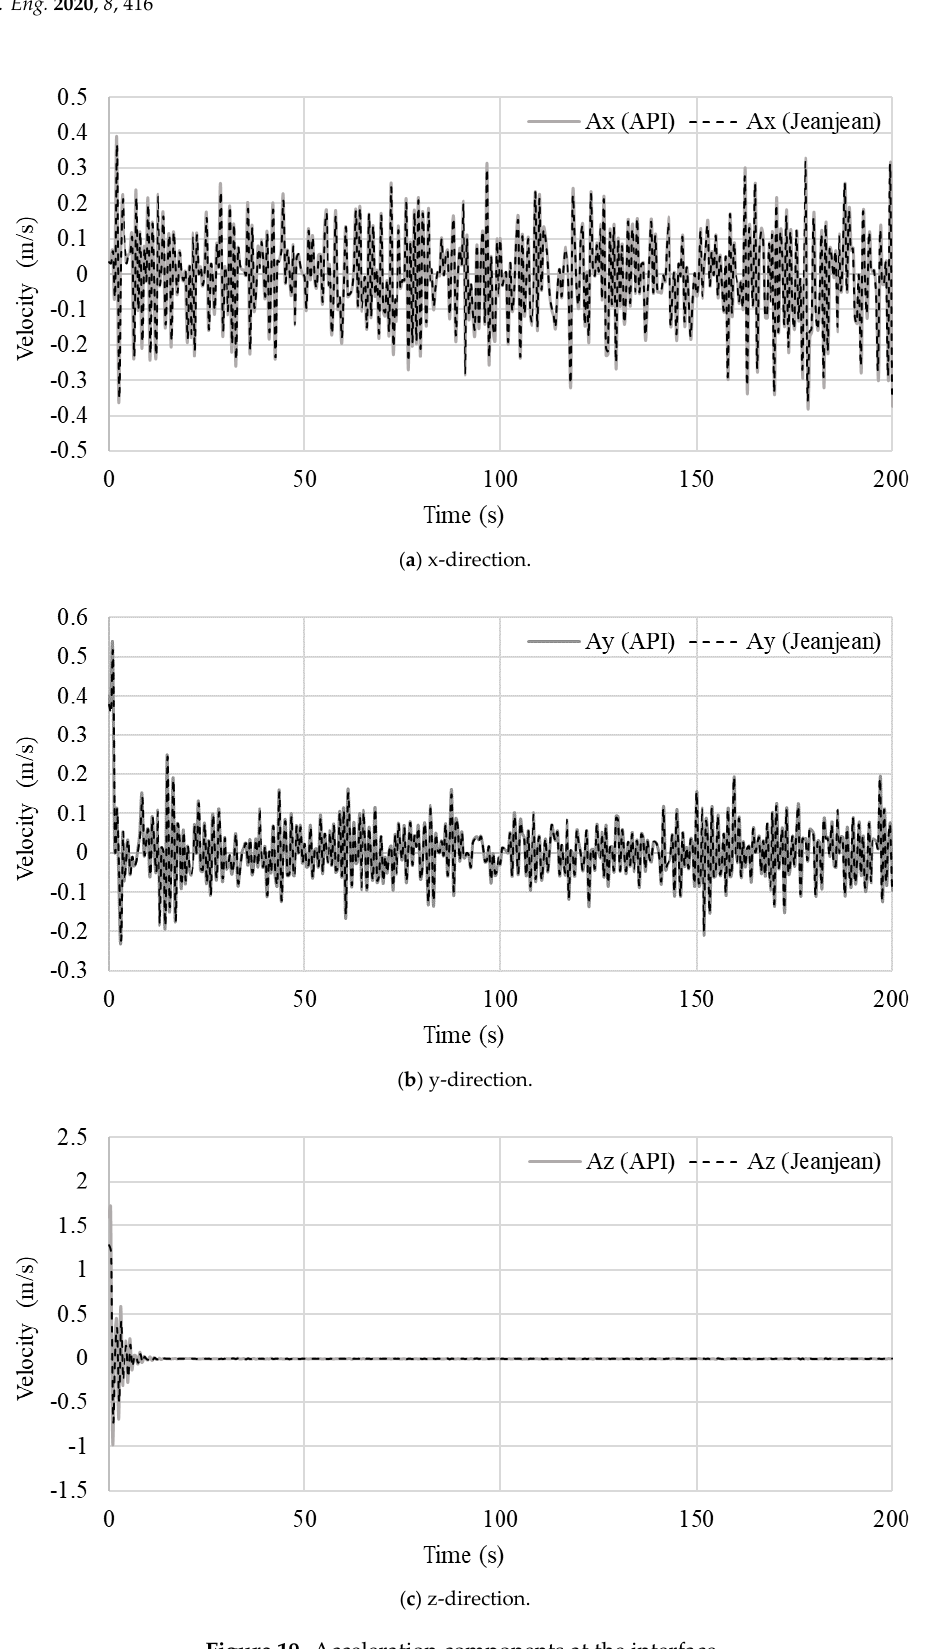
Figure 19. Acceleration components at the interface.